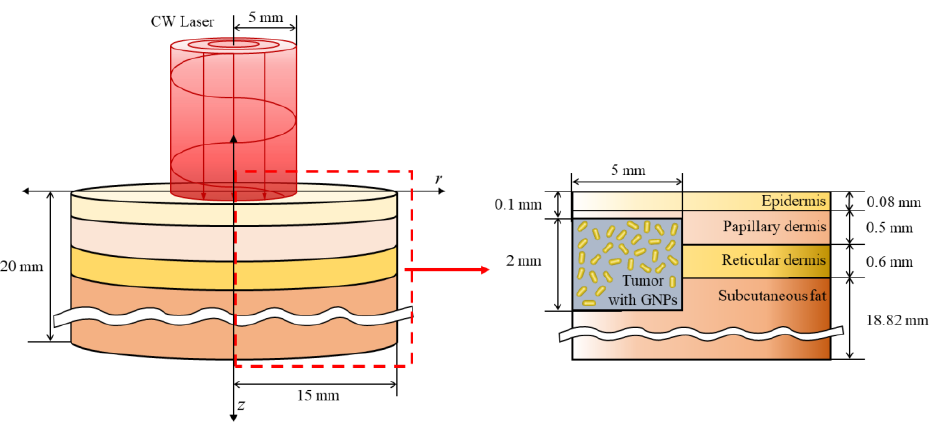
Figure 6. Schematic of the numerical model. Table 1. Depth, thermal, and optical properties of skin layers and tumor [10,32 – 38] .